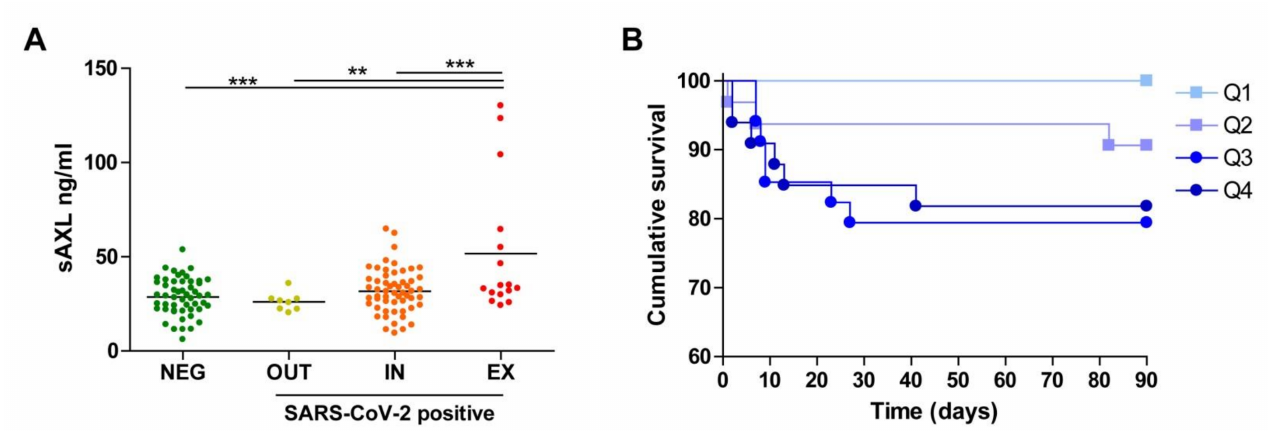
Figure 2. Plasma soluble AXL (sAXL) concentration in consecutive emergency patients and survival curves related to quartile AXL values. ( A ) sAXL plasma concentration was measured in all patients and compared using one-way Anova. **, p < 0.01; ***, p < 0.001. ( B ) Survival plot of all patients divided by sAXL quartile at admission. The sAXL survival curves were different in a logrank test ( p < 0.048) and the Q4 survival was significantly different only to the Q1 curve ( p = 0.011).